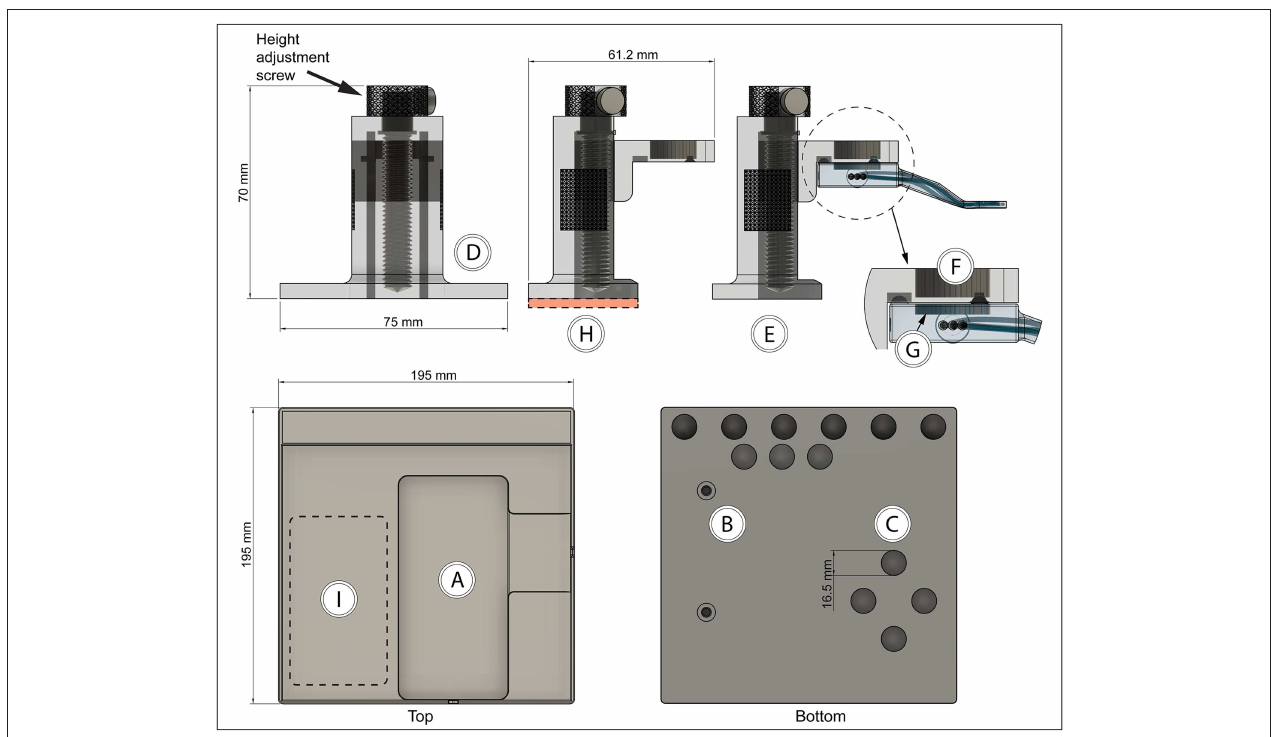
FIGURE 4 | Vacuum window holder and operating table with magnetic attachment points (A) Heating pad cutout, (B) M5 thread inserts, (C) neodymium magnet cutouts, (D) height-adjustable vacuum window holder—front view, (E) holder side view with vacuum window attached, (F) neodymium magnet position on holder, (G)